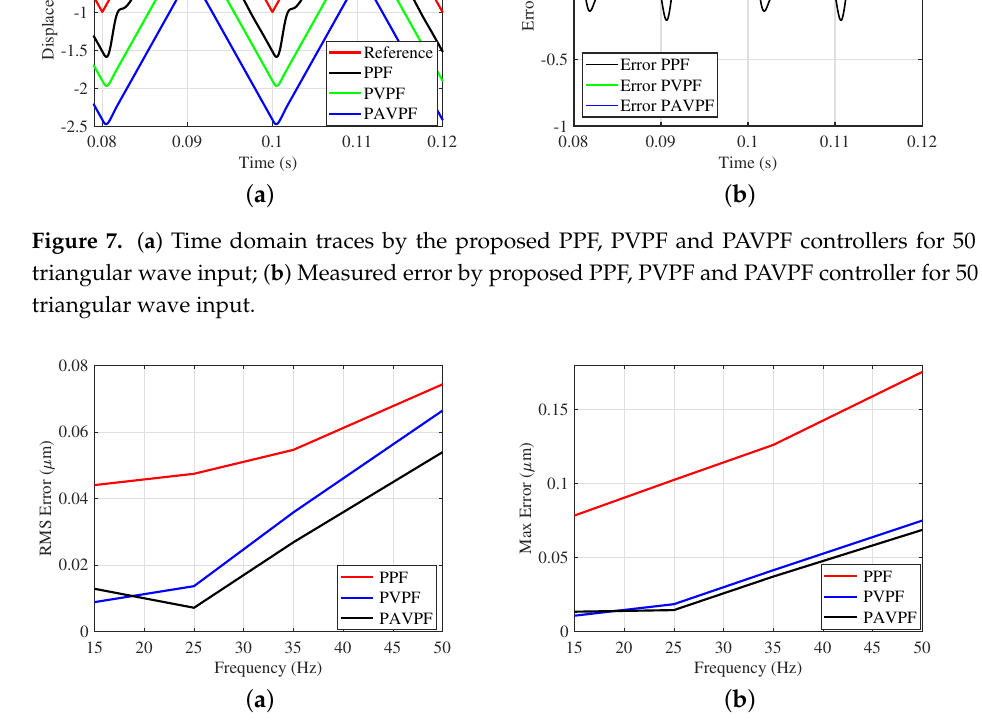
Figure 8. RMS error ( a ) and Maximum error ( b ) trends while tracking triangular trajectories of fundamental frequencies ranging from 5 Hz to 50 Hz and a displacement range of ± 1 µ m for PPF + I, PVPF + I and PAVPF + I schemes designed using the presented eigenstructure assignment